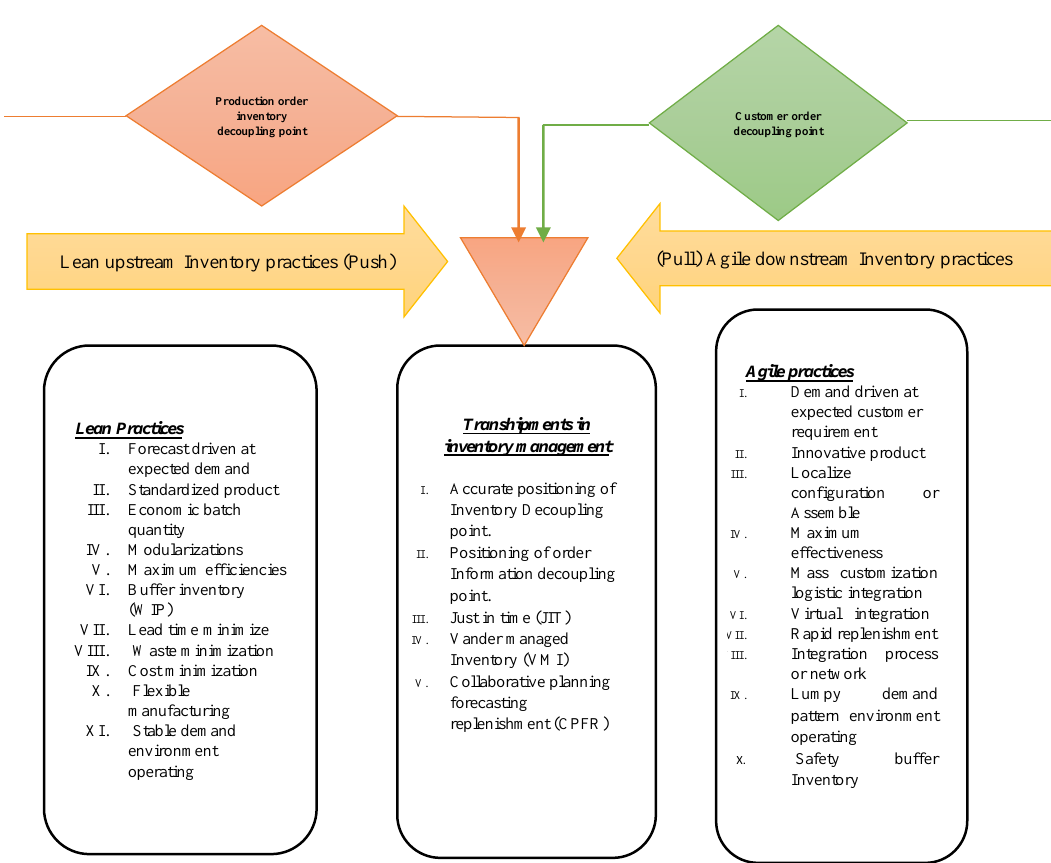
Figure 1. Trade off b/w lean and agile supply chain in inventory